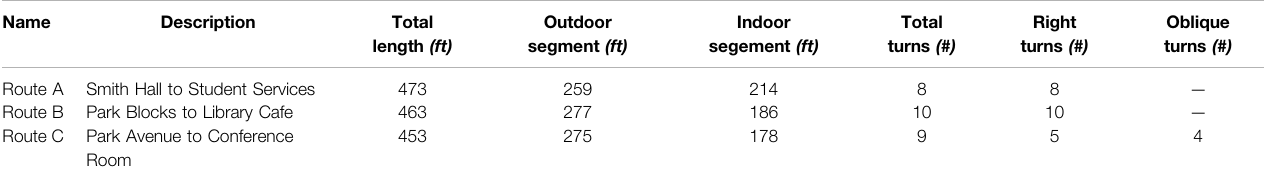
TABLE 1 | Characteristics of the three way fi nding routes that we asked our case study participant to complete in terms of overall length, the length of indoor and outdoor segments, total number of turns, and the number of right-angled and oblique